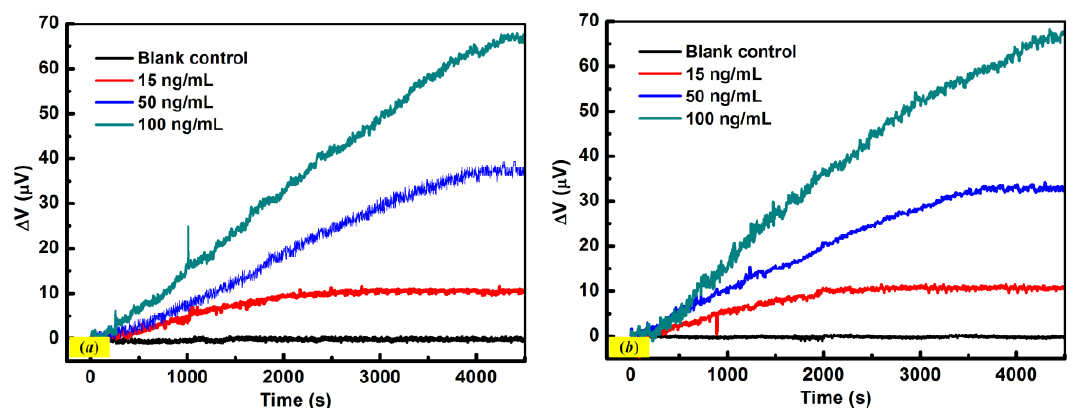
Figure 8. The response curves of immunosensors for the detections of IgG (15, 50, and 100 ng/mL) in ( a ) 0.02 M PBS solution with pH 7.4 and ( b ) 0.01 M PBS solution with neutral pH.